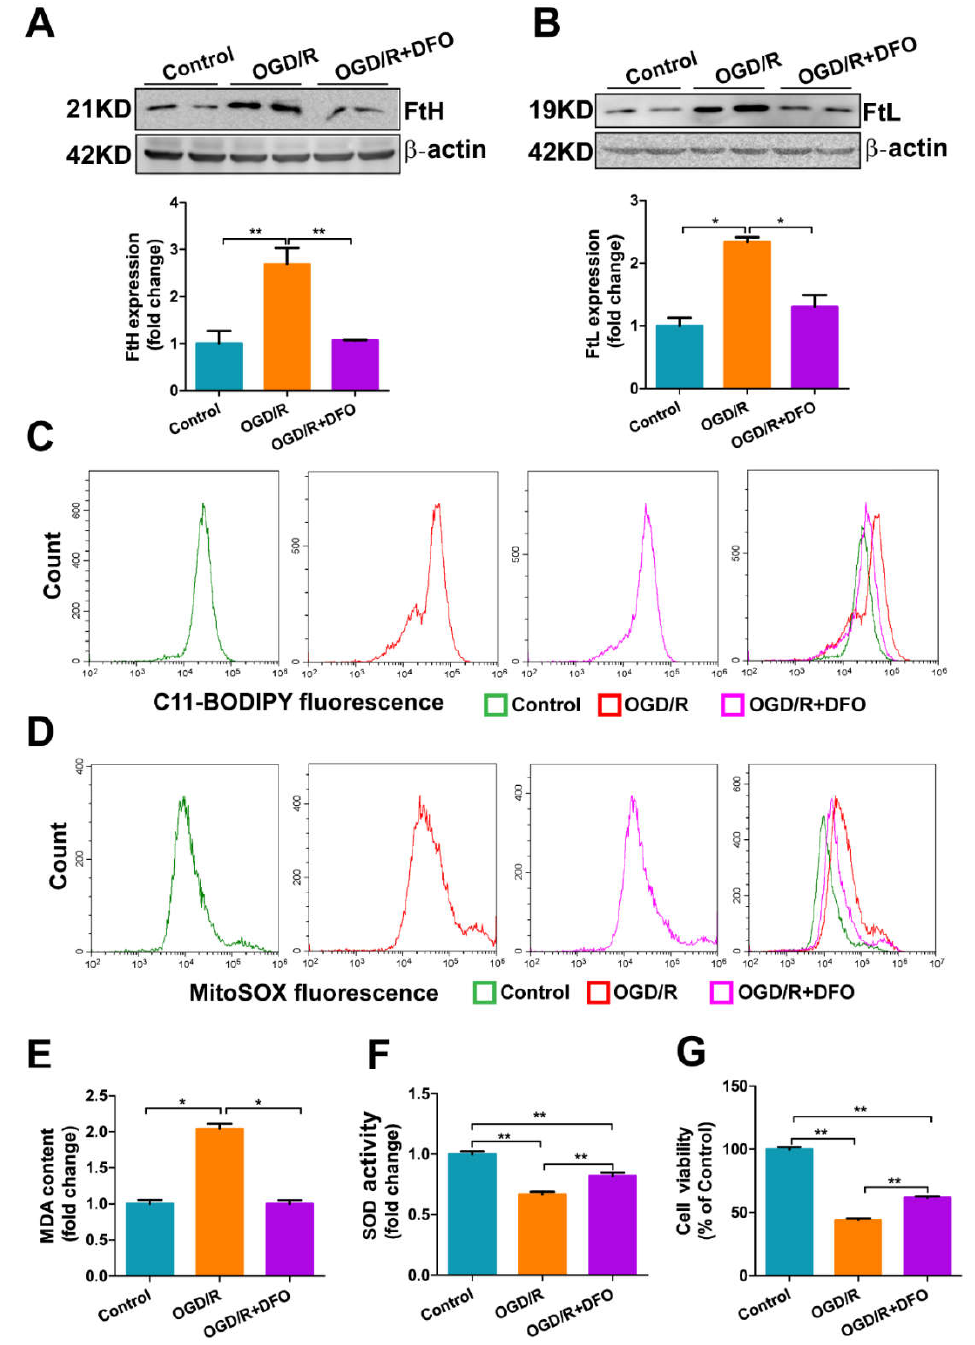
Figure 7. DFO treatment attenuates OGD/R-induced oxidative damage in bEnd.3 cells. bEnd.3 cells were subjected to OGD treatment for 9 h and then reoxygenation in the presence of 5 µM DFO for 2 h. Western blot and densitometric analyses of ( A ) FtH and ( B ) FtL. The results are normalized to the β -actin levels and the data are expressed relative to the mean value in the control group ( n = 4). ( C ) Lipid ROS and ( D ) mitochondrial ROS levels were assessed in OGD/R-treated bEnd.3 cells with or without added DFO by flow cytometry using C11-BODIPY and MitoSOX, respectively; representative data from one of three experiments are shown. ( E ) MDA and ( F ) SOD activity were analyzed by commercial assays and the data are expressed relative to the mean value in the control group ( n = 3). ( G ) Cell viability was determined using the MTT assay ( n = 6). The results are presented as the mean SEM. * p < 0.05, ** p < 0.01.